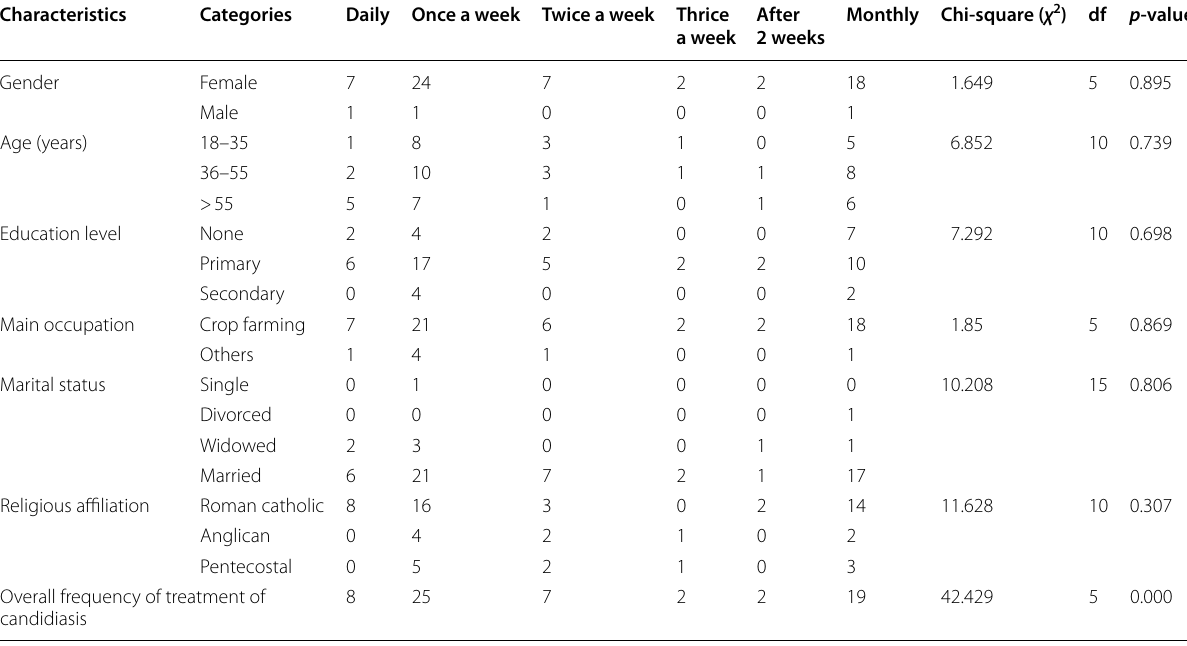
Table 2 Frequency of herbal treatment of candidiasis in relation to herbalists’ socio-demographics Characteristics